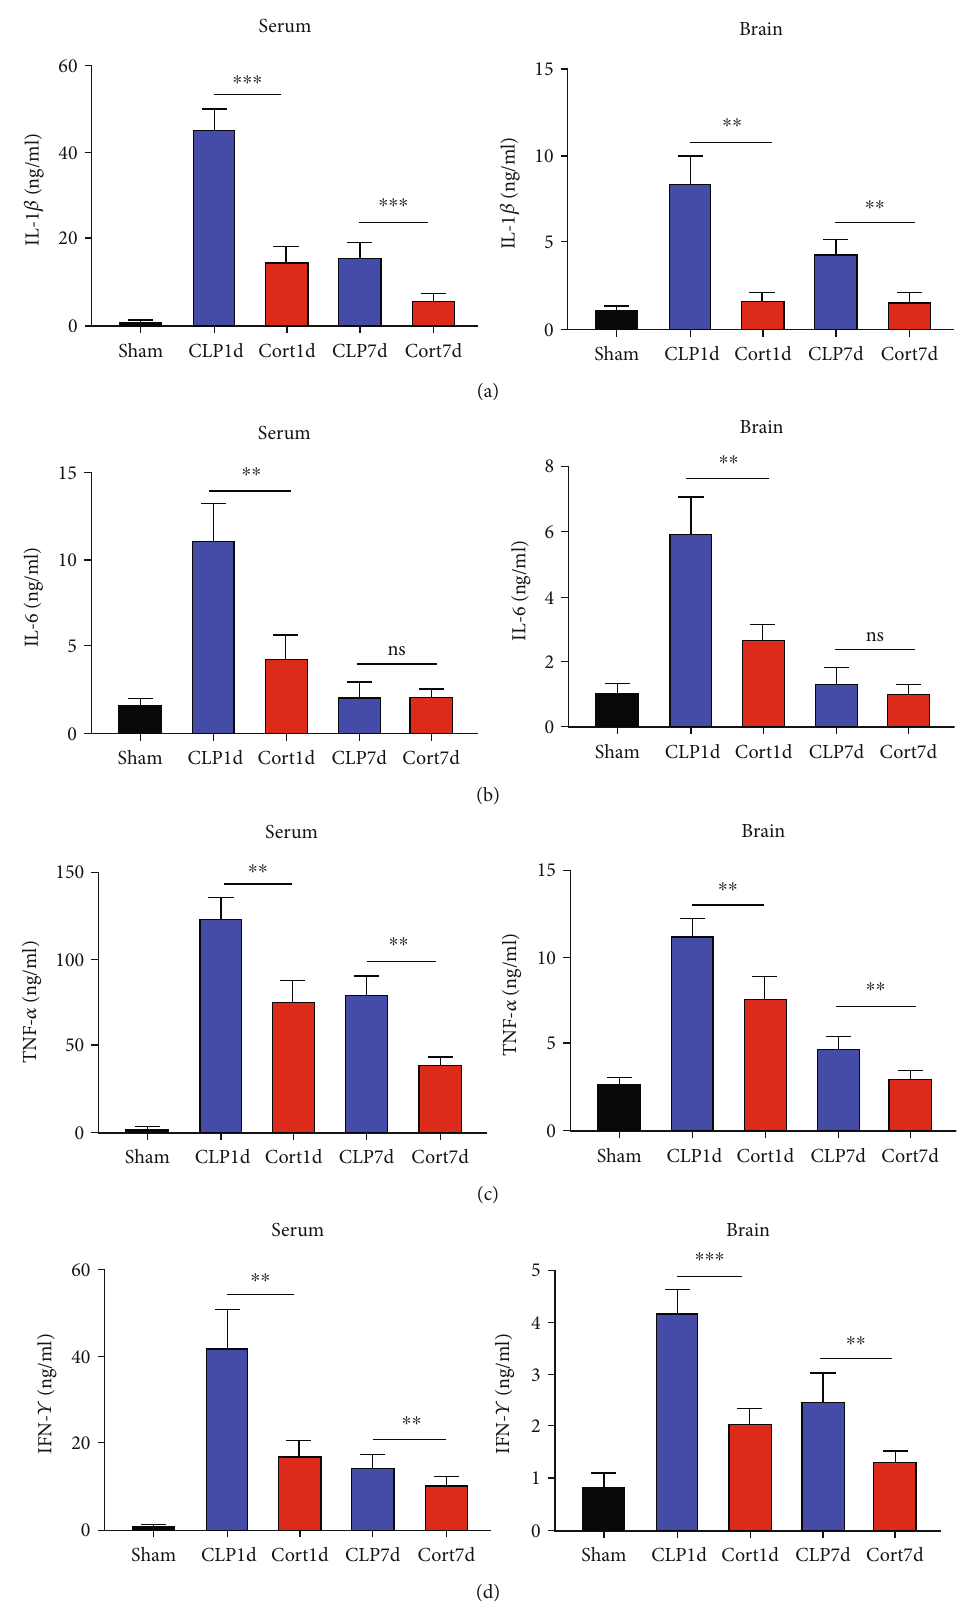
Figure 3: Cortistatin treatment decreased systemic (serum, left panels) and regional (brain, right panels) in fl ammatory cytokines levels. Levels of IL-1 β (a), IL-6 (b), TNF- α (c), and IFN- γ (d), respectively. ∗∗ P <